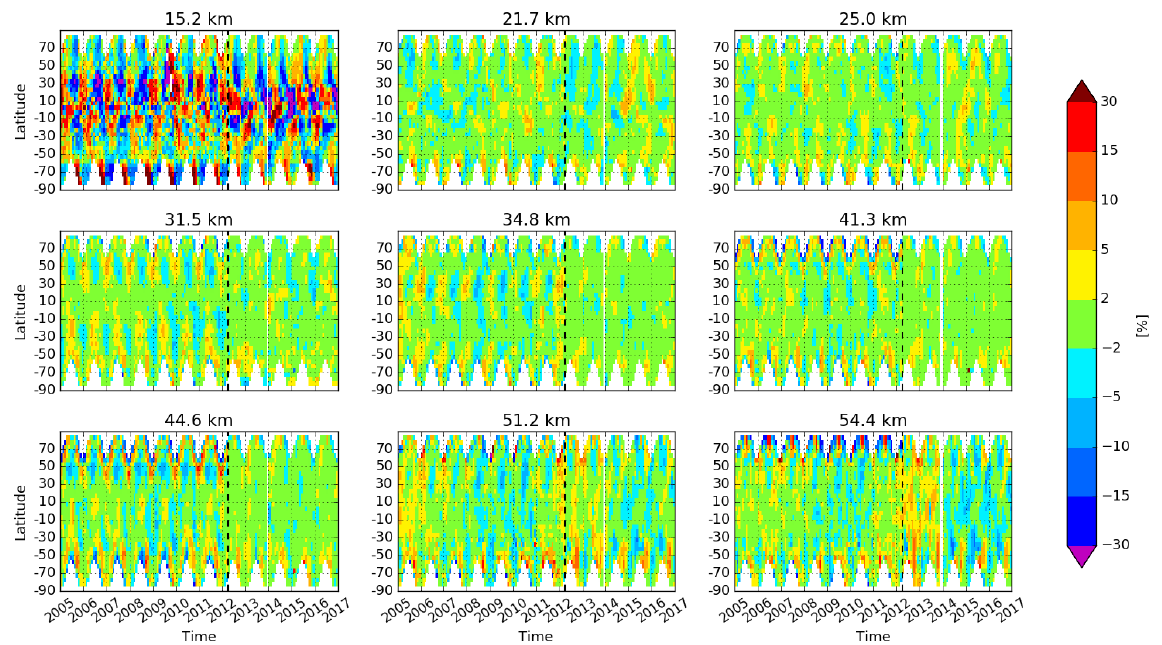
Figure 3. Relative differences of the debiased merged time series (“plain-debiasing” approach) with respect to MLS as a function of latitude for several altitudes, computed according to Eq. (3). The vertical dashed lines indicate the transition between the SCIAMACHY and OMPS- LP data sets. MLS data have been offset to SCIAMACHY before the comparison.